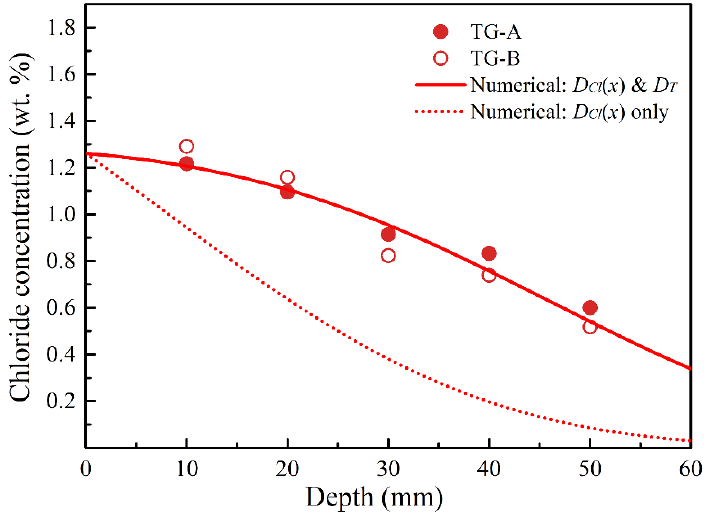
Figure 8. Chloride concentration profile calculated by the modified equation of Fick’s second law, compared with measured data points of the TG condition. (Single-column